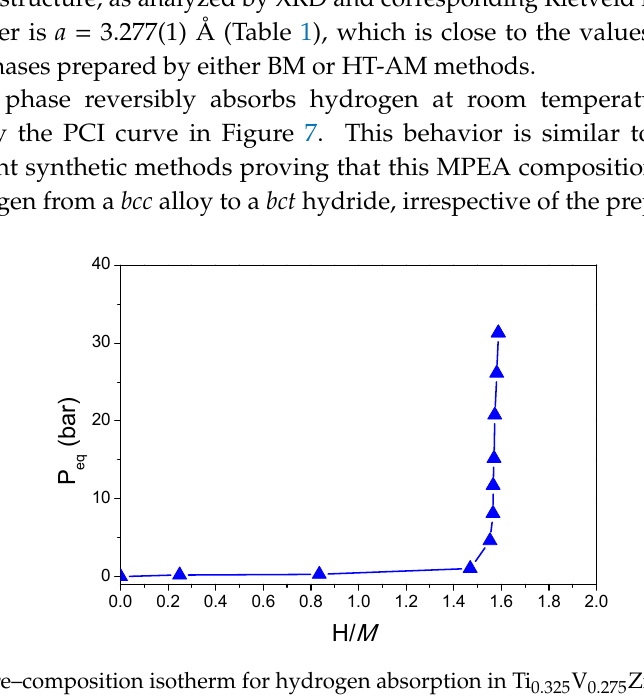
Figure 7. Pressure–composition isotherm for hydrogen absorption in Ti 0.325 V 0.275 Zr 0.125 Nb 0.275 (RBM) at 25 °C.